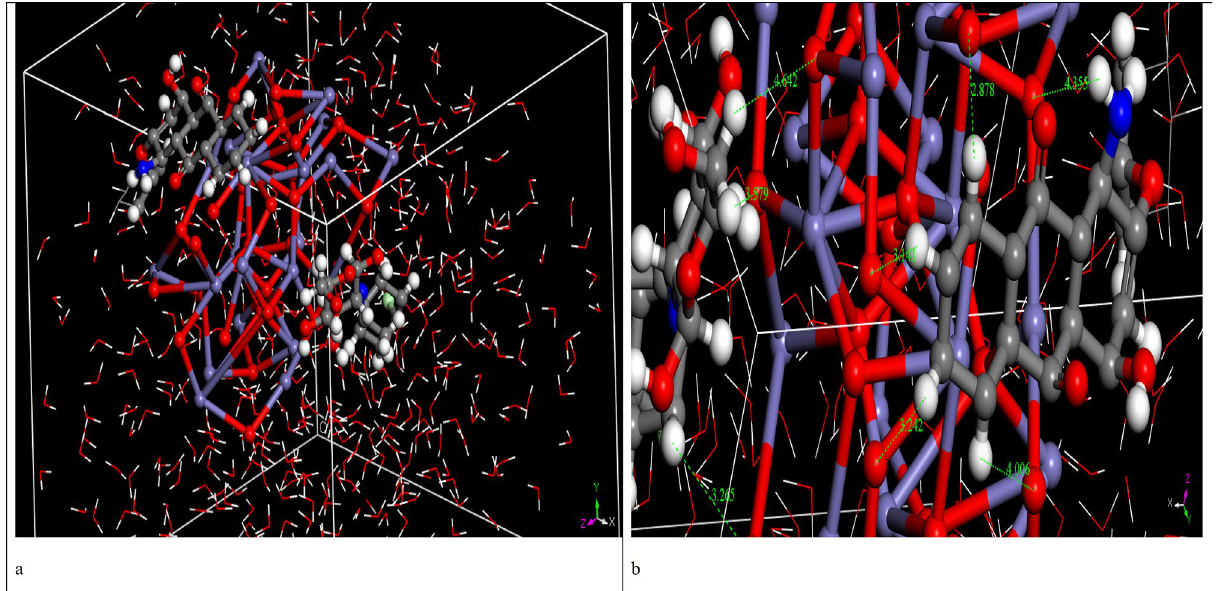
Figure 18. MD snapshots at 10 ns of the adsorption of DR molecule on the CF surface, the bond length is in Angstroms.